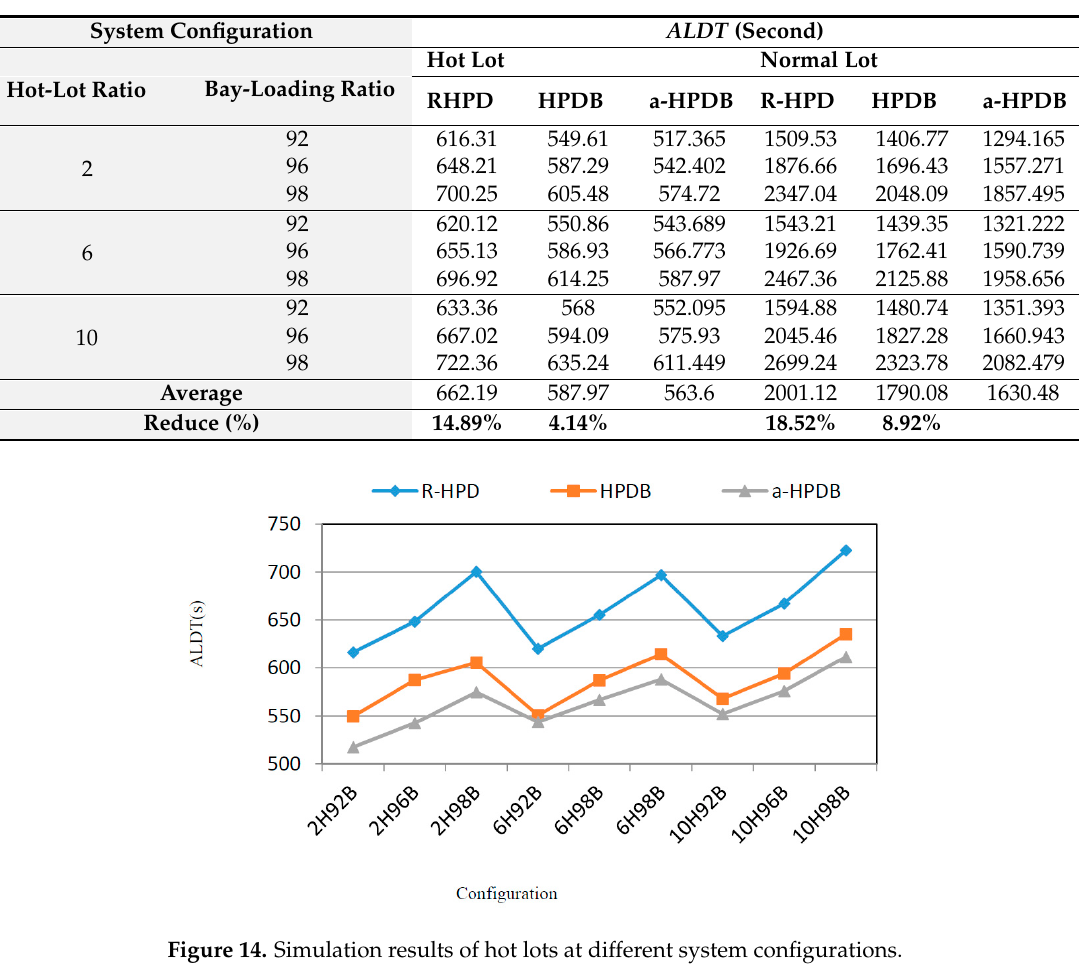
Table 1. Comparisons of different methods.